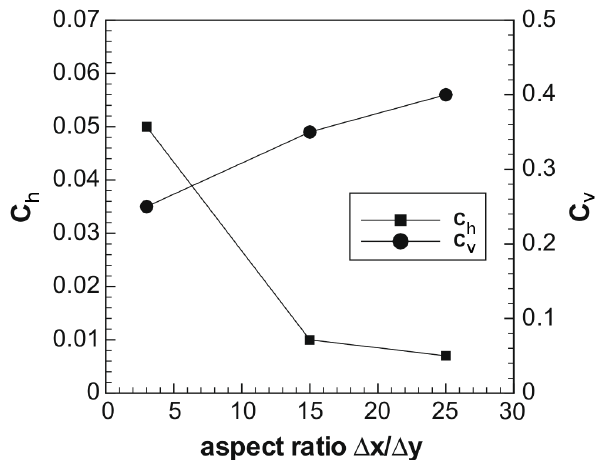
Fig. 1. Variation in optimal value constants, C h and C v , with the Fig. 1. Variation of optimal values constants C h and C v with the grid grid anisotropy.